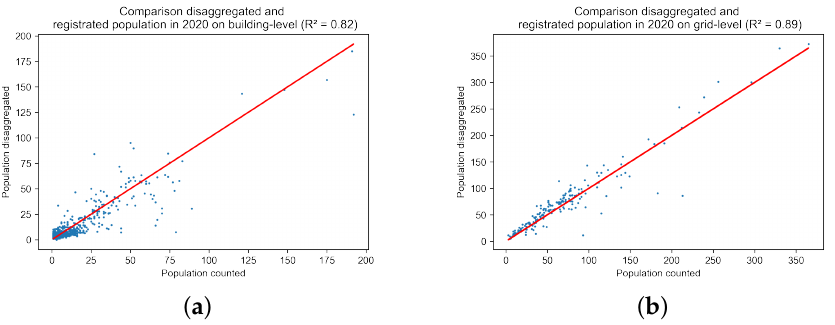
Figure 16. Comparison disaggregated and recorded population data correlation examples.